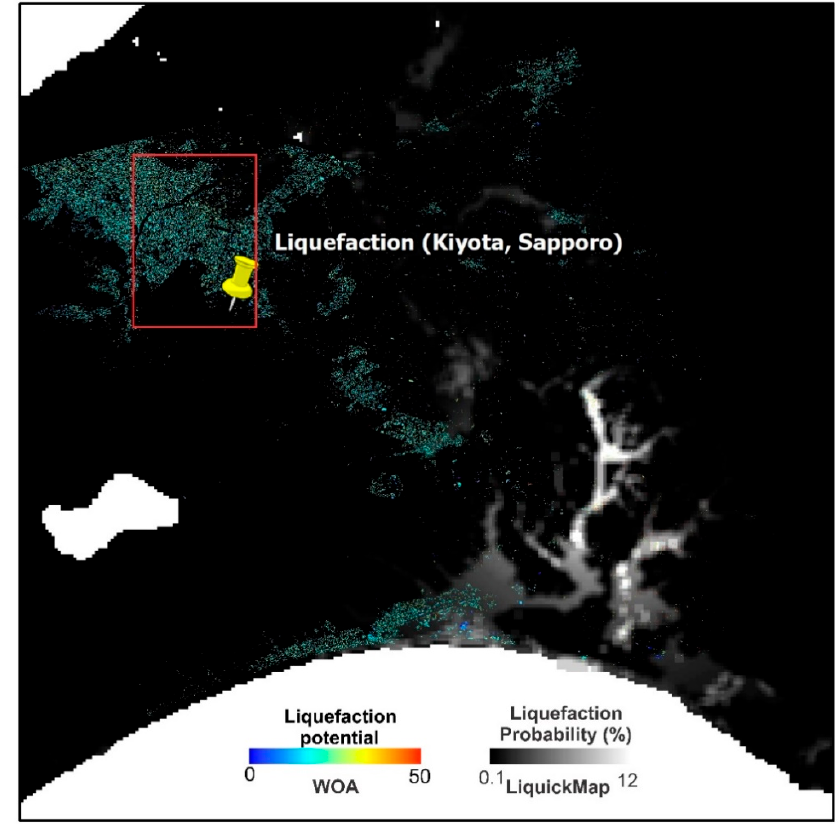
Figure 5. The WO map (track 116) of Hokkaido masked by urban footprints (Geospatial Information Authority of Japan, GSI) overlain on the initial LiquickMap. The yellow pin and red box (Figure 6) show the location of the Kiyota ward in Sapporo, which experienced severe liquefaction activity.